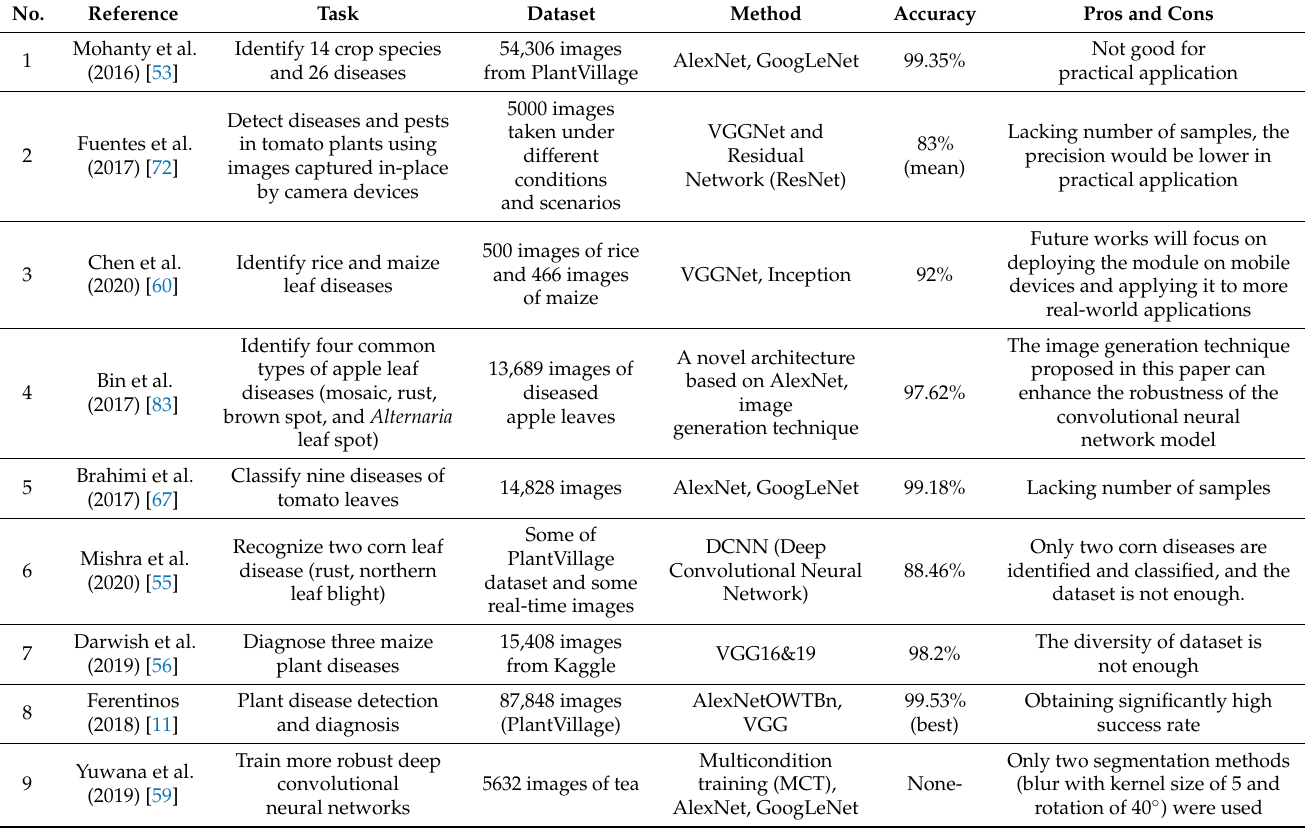
Table 5. Studies on different CNN methods applied to plant leaf disease